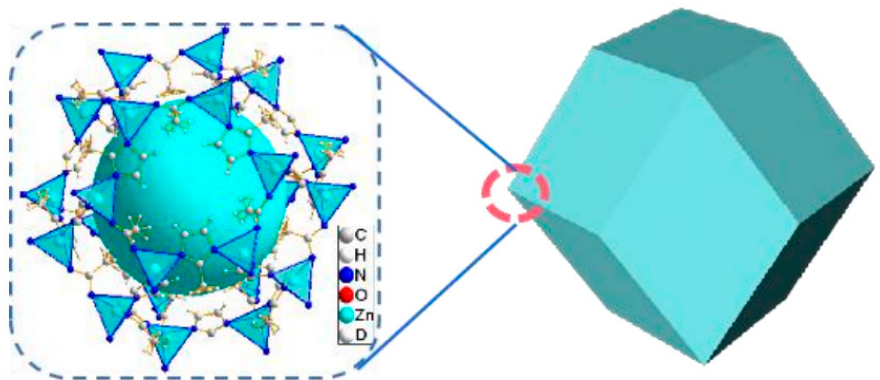
Figure 2. Schematic diagram of ZIF-8 structure.